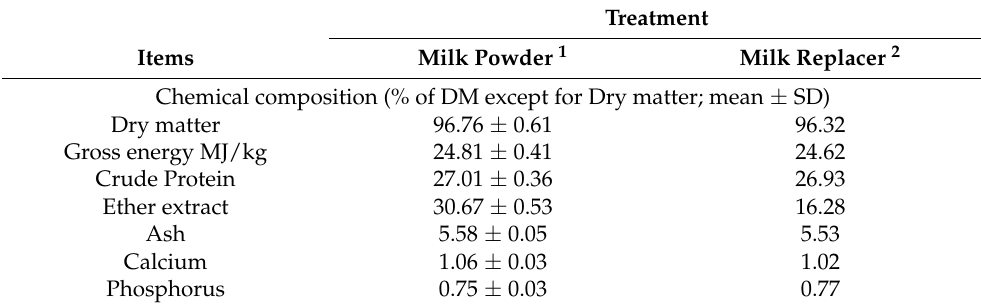
Table 1. Ingredient and chemical composition of milk and milk